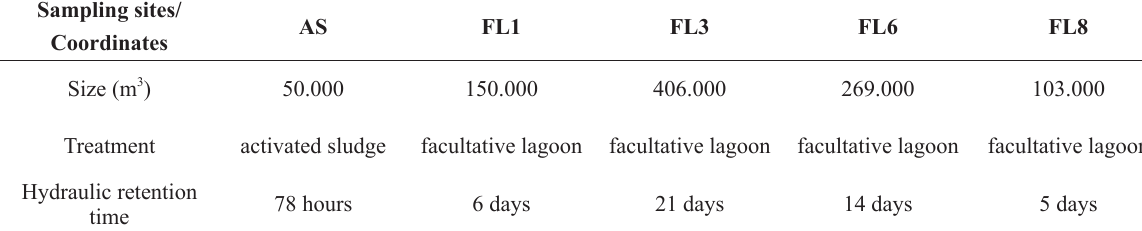
Sampling sites points and their main characteristics.